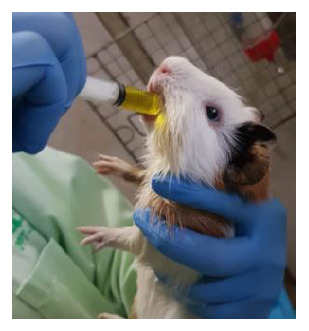
Administration of olive oil to a guinea pig.